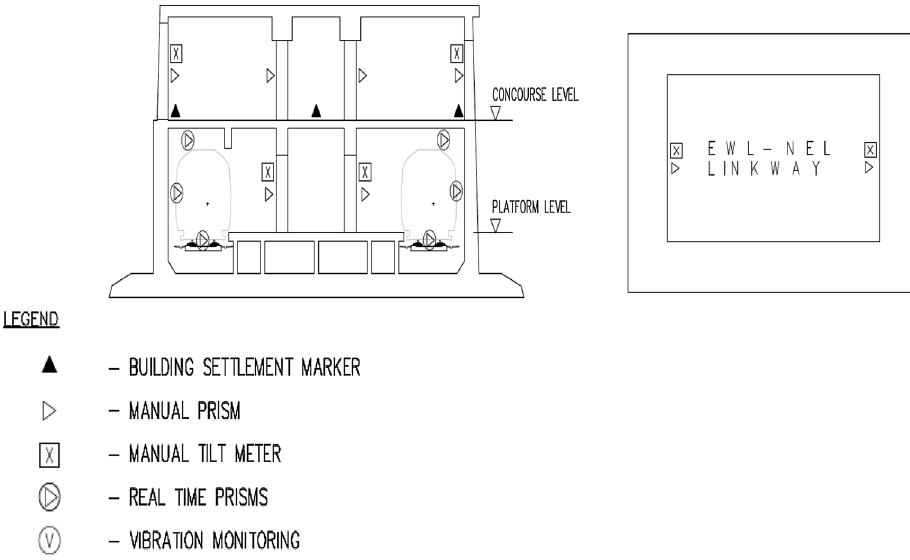
Fig. 11 Instruments in the EWL station, trackside and linkway